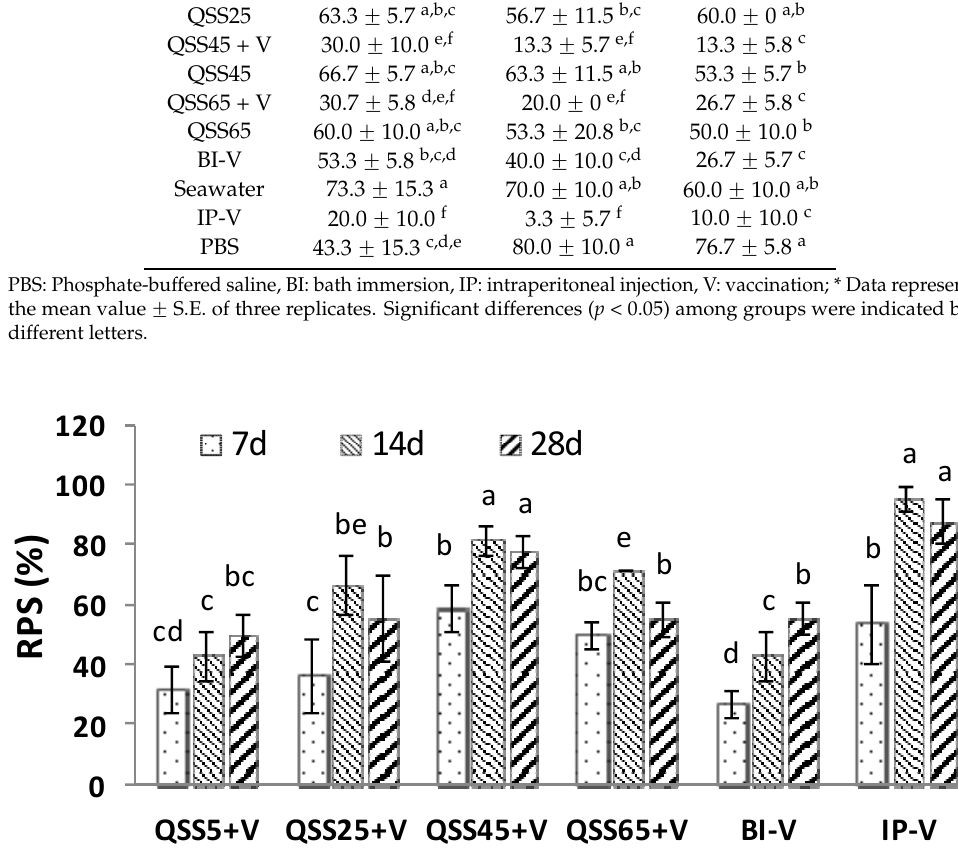
Figure 1. RPS (%) in each group on days 7, 14 and 28 post-vaccination challenged with pathogenic V. anguillarum. Significant differences ( p < 0.05) in RPS among various groups were indicated by different letters. Data represent the mean value ± S.E. of three replicates.